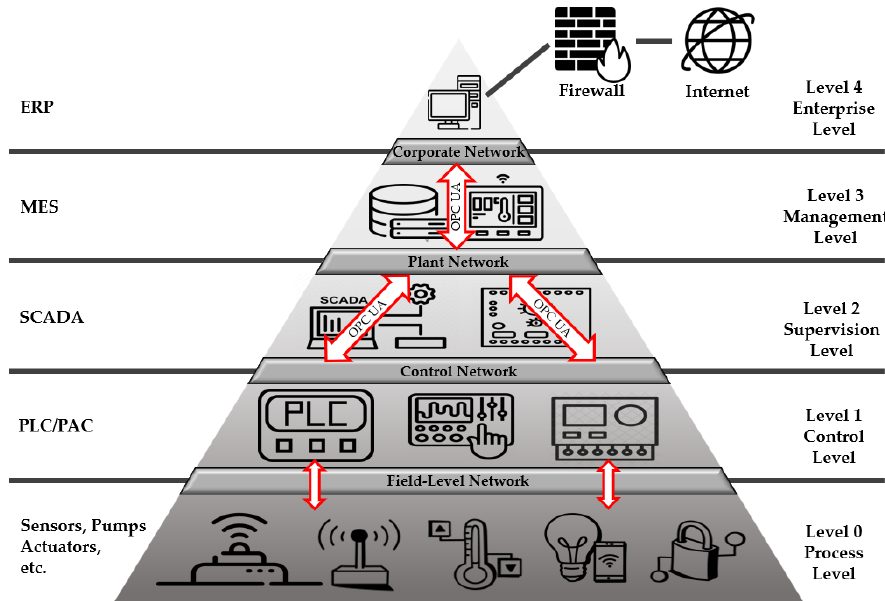
Figure 2. Architecture with integrated OPC in facility automation.